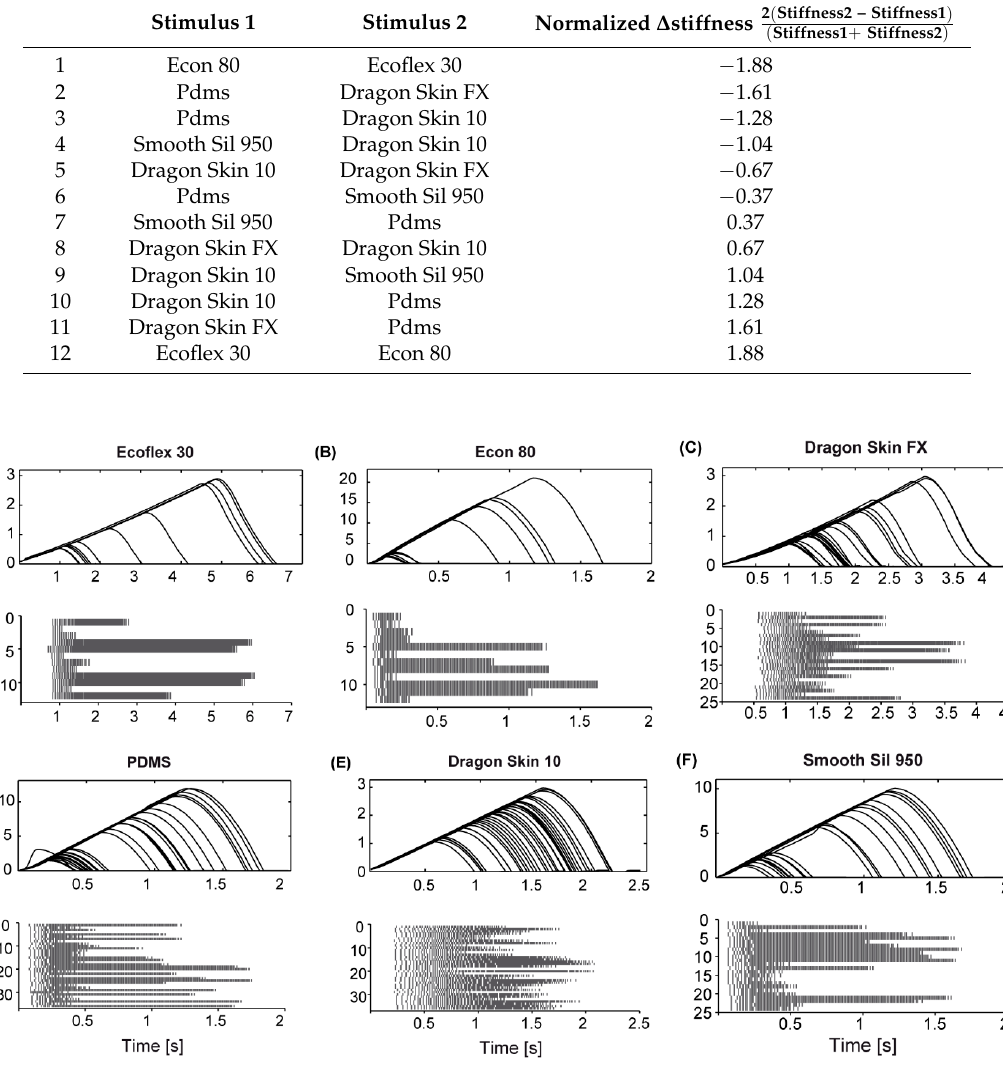
Figure 3. Conversion of the acquired normal forces in spike trains, per each selected rubber. The spikes were then delivered to the wearer of the haptic glove by means of encapsulated piezoelectric transducers. ( A ) Different indentations of the same rubber (Ecoflex 30) with different force threshold levels (upper panel), and corresponding spike trains per each rubber indentation (lower panel); ( B ) same of panel ( A ), for rubber Econ 80; ( C ) same of panel ( A ), for rubber Dragon Skin FX; ( D ) same of panel ( A ), for rubber Polydimethylsiloxane (PDMS); ( E ) same of panel ( A ), for rubber Dragon Skin 10; ( F ) same of panel ( A ), for rubber Smooth Sil 950. Spike activity was higher in the middle of the indentation, when the force level reached the threshold. The stimulation patterns shown in this figure were paired and presented to the participant according to the combination possibilities discussed in Figure 3. Note how the spike activity changed passing from a softer rubber (i.e., Ecoflex 30, in panel ( A )) to a harder rubber (i.e., Econ 80, in panel ( B )). Please note that in panel ( D ) (upper panel) there is a single non-coherent slope, probably an outlier of the measured Fz during the automatized indentation protocol.